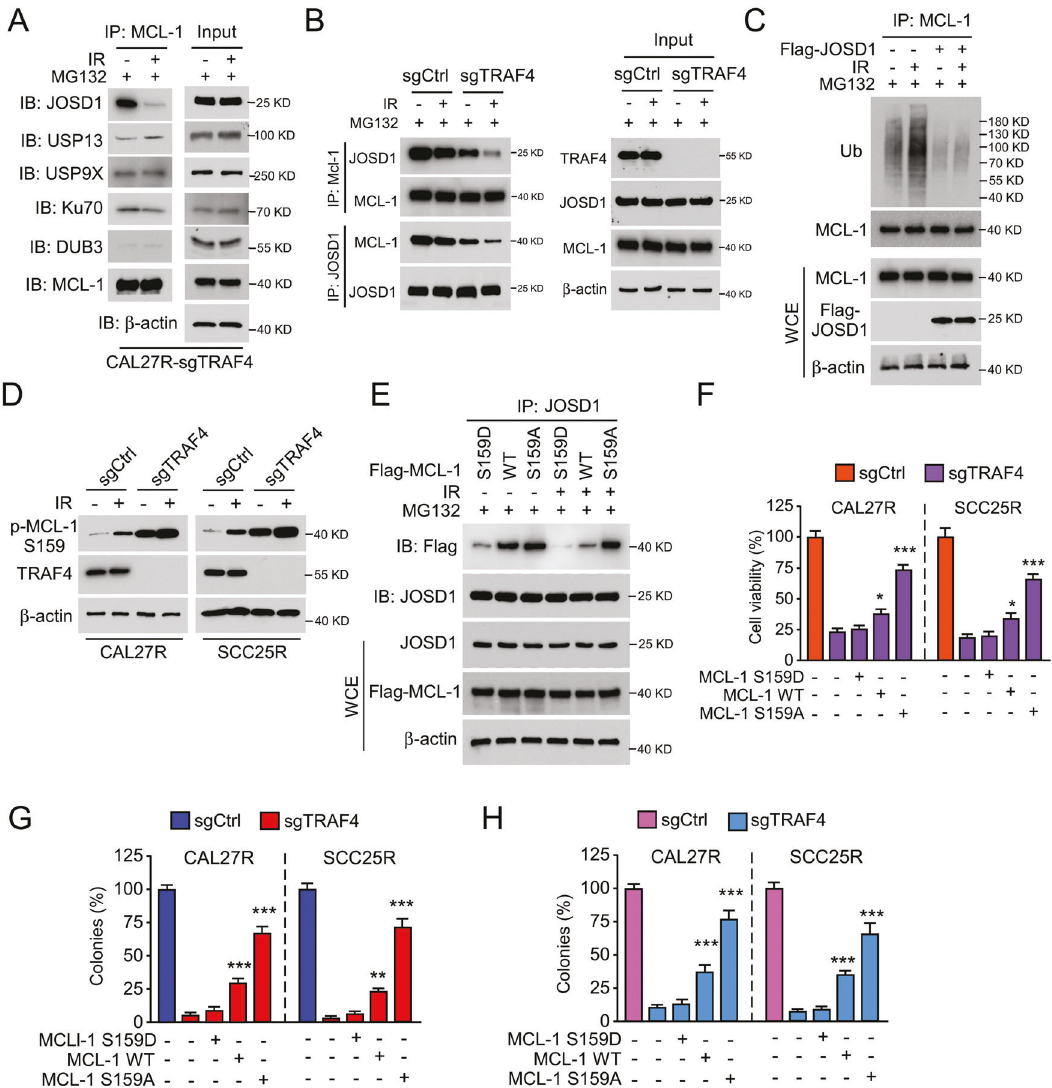
Fig. 5 Irradiation disrupts the interaction between JOSD1 and MCL-1. A TRAF4 knockout CAL27R cells were treated with/without IR (2 Gy) for 20 min, and WCE was subjected to co-immunoprecipitation (Co-IP) analysis. B Immunoblotting for IP-mediated MCL-1 and JOSD1 expression in TRAF4 knockout CAL27R cells treated with/without IR (2 Gy) for 20 min. C CAL27R cells were transfected with Flag-JOSD1 for 48 h, followed by IR (2 Gy) treated for 20 min. IP assay was performed to detect MCL-1 ubiquitination. D Immunoblotting for p-MCL-1 S159 expression in TRAF4 knockout CAL27R and SCC25R cells treated with/without IR (2 Gy) for 72 h. E CAL27R cells were transfected with Flag- MCL1 WT, Flag-MCL1 S159D and Flag-MCL1 S159A for 48 h, followed by IR (2 Gy) treated for 20 min. WCE was subjected to co- immunoprecipitation (Co-IP) analysis. F – H Transfected with Flag-MCL1 S159A mutant restored proliferation of TRAF4 knockout OSCC cells. TRAF4 knockout CAL27R and SCC25R cells were transfected with Flag-MCL1 WT, Flag-MCL1 S159D and Flag-MCL1 S159A for 48 h. MTS assay was used to determine the cell viability ( F ), plate colony formation assay to analyze the colony formation ( G ) and soft agar assay to assess the anchorage-independent cell growth ( H ). All data are means ± s.e.m. ** p < 0.01, *** p < 0.001, a signi fi cant difference between groups as